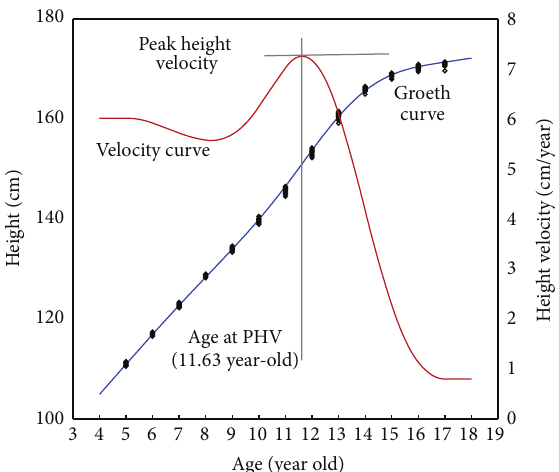
Figure 3: An example of estimation of age at PHV. The growth curve was estimated by cubic spline-fitting using all prefectural data for 5–17-year-old children from 2006 to 2013. This is an example of males in Hokkaido prefecture.